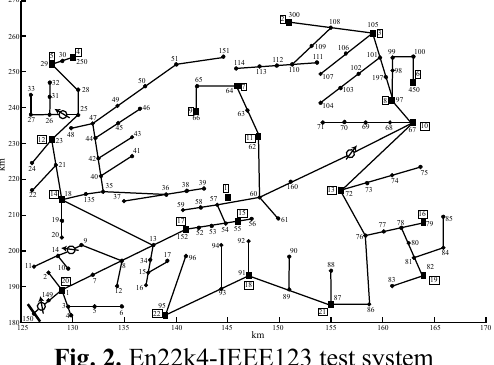
Fig. 2. En22k4-IEEE123 test system